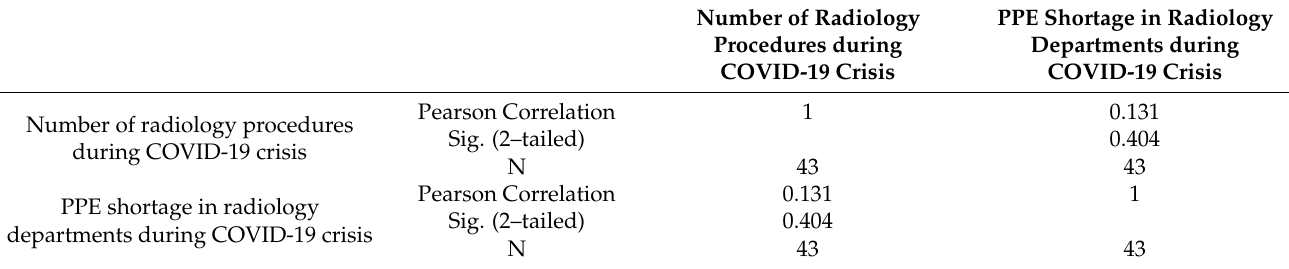
Table 5. Correlation between the number of radiology procedures being conducted due to COVID-19 crisis and PPE shortage in radiology